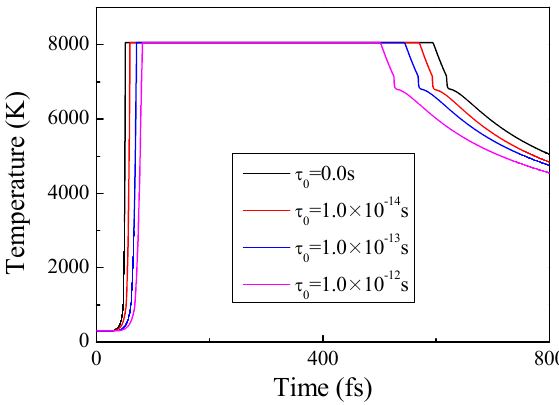
Figure 5. The surface temperature characteristics of the target under different relaxation times ( F fluence = 10 J/cm 2 ).